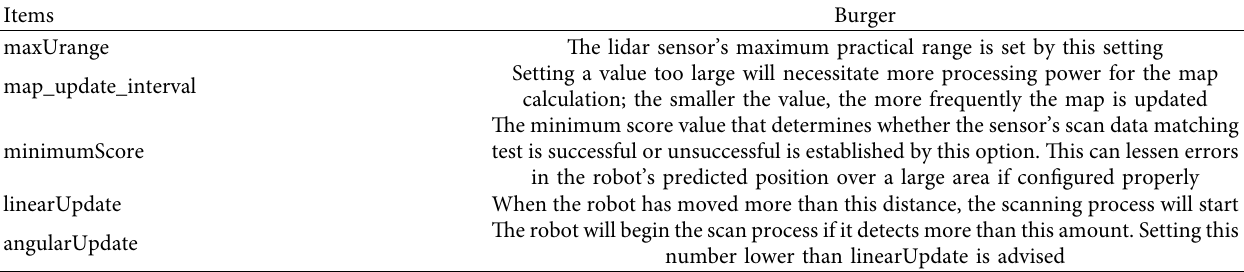
Figure 17: Estimate initial pose. Table 5: Specifcation of Turtlebot3 Burger.